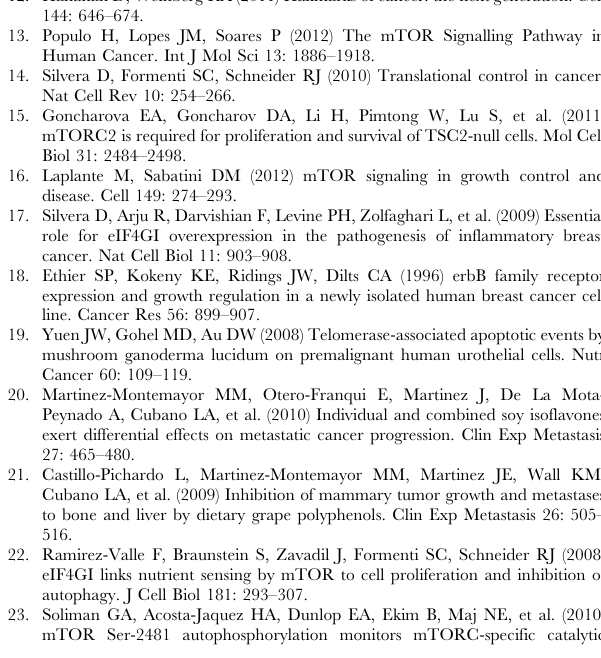
(TIF) Figure S4 Effect of Reishi in the expression of Akt in vivo . Equal amount of protein from each sample was used for western blot analysis with antibodies against total and phosphor- ylated Akt. (TIF) Table S1 In vitro expression patterns of PI3K/Akt pathway genes. This table includes all genes that show tendency to be significantly up- or down- regulated with 0.5 mg/ml Reishi at a P value between 0.06 and 0.08 when where compared to vehicle controls. See Table 1 for genes that are significantly regulated and are analyzed at 2 1.4 $ 1.4 log 2 -fold changes. (DOCX) Table S2 In vivo expression patterns of PI3K/Akt pathway genes. This table includes all genes that show tendency to be significantly up- or down- regulated with 0.5 mg/ml Reishi at a P value between 0.06 and 0.08 when where compared to vehicle controls. See Table 2 for genes that are significantly regulated and are analyzed at 2 1.3 $ 1.3 log 2 -fold changes.